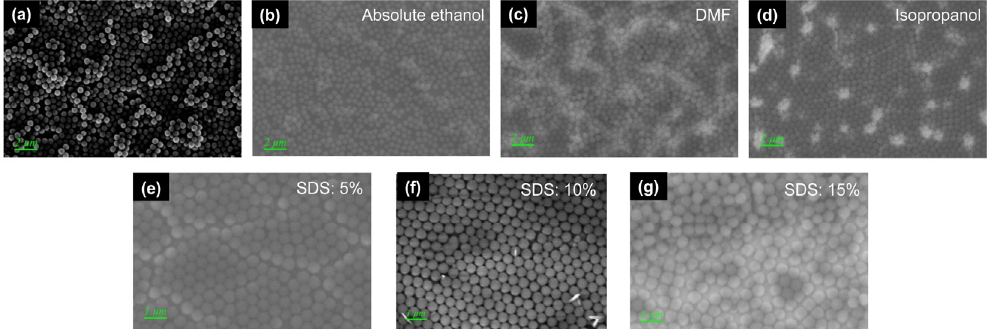
Figure 2. ( a – d ) SEM images of the results of SiO 2 spherical film formation under different dispersants. ( e – g ) SEM images of the results of SiO 2 spherical film formation in SDS at different concentrations.